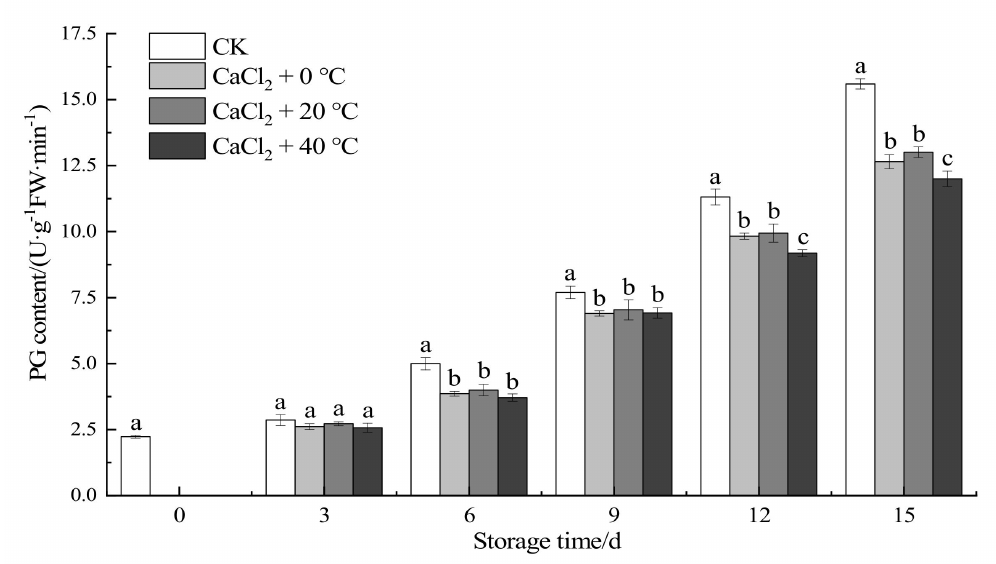
Figure 5. Effect of the different treatments on the PG activity of fresh-cut “Xuebai” cauliflower florets. Error bars indicate standard deviation (SD); the statistical significance between the four groups that passed the Tukey significance test is expressed in different lowercase letters, and the significance level is p <